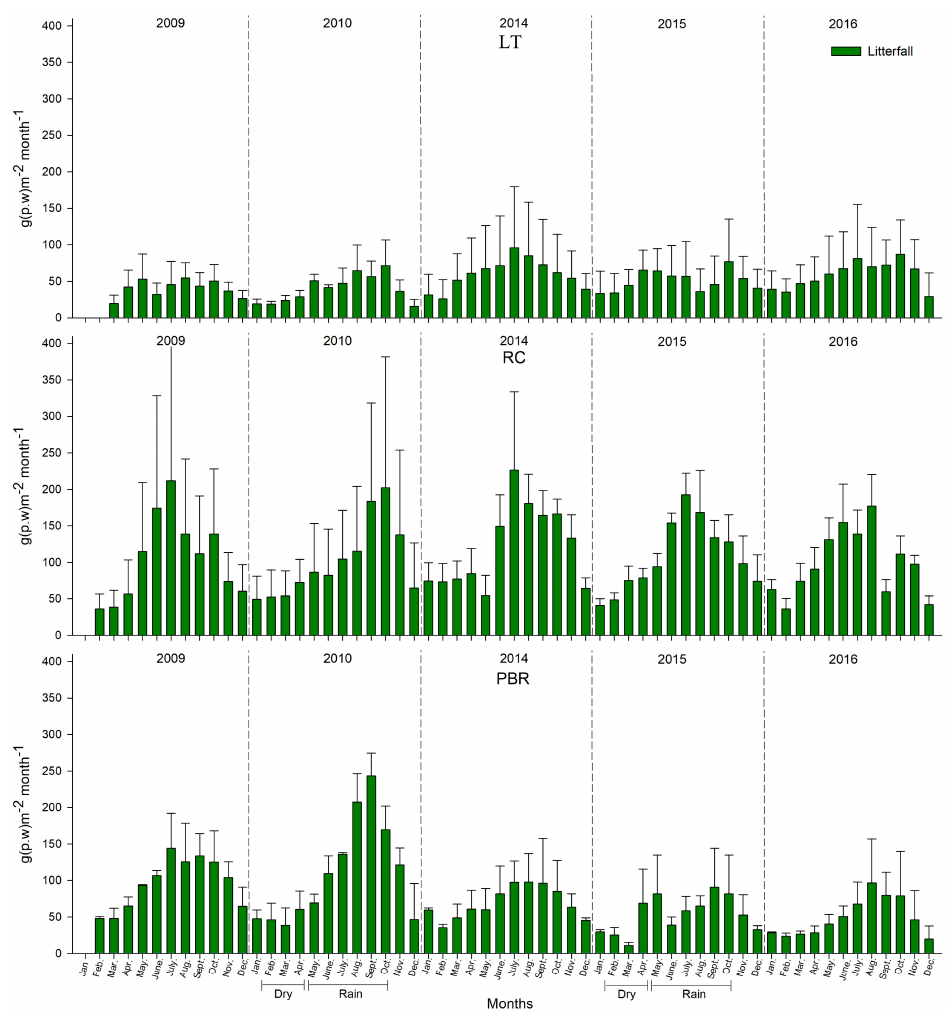
Figure 4. Total litterfall production in seven mangrove forests along the coast of Campeche, México from 2009 to 2010 and 2014 to 2016. The southern region includes Laguna de Terminos, and the northern region includes Rio Champoton and the Los Petenes Biosphere Reserve.